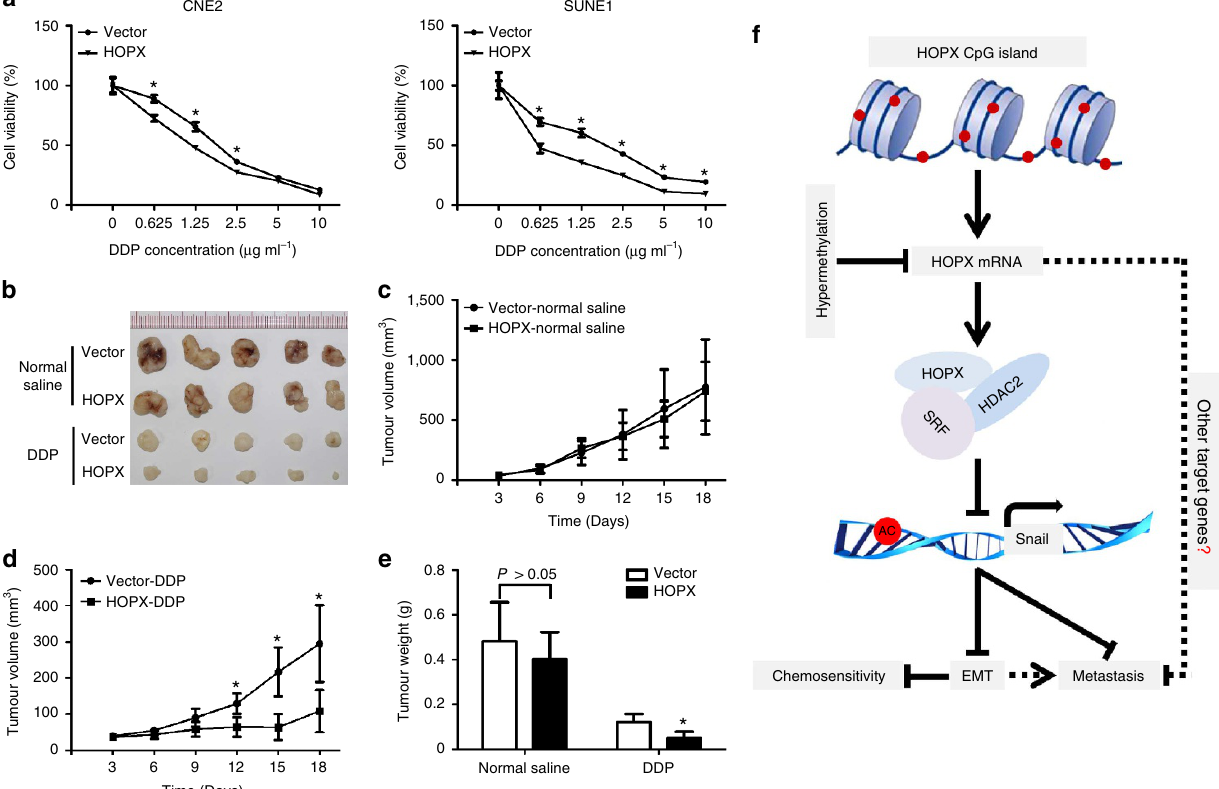
Figure 9 | HOPX enhances the sensitivity of NPC cells to DDP. ( a ) Dose–response curves of CNE2 and SUNE1 cells that stably overexpressed the vector or HOPX following DDP (0, 0.625, 1.25, 2.5, 5 and 10 m gml (cid:3) 1 ) treatment. Mean ± s.d.; * P o 0.01 compared with vector; Student’s t -tests. ( b – e ) CNE2 cells stably overexpressed the vector or HOPX were injected into the dorsal flank of the mice. The mice were randomly divided into four groups ( n ¼ 5 per group) and treated with normal saline or DDP (4mgkg (cid:3) 1 ). These data are representative of five independent experiments (each mouse sample was considered as an independent experiment). ( b ) Representative picture of xenograft tumours in nude mice. ( c , d ) The growth curves of the tumour volumes in normal saline ( c ) or DDP ( d ) treatment group. Mean ± s.d.; * P o 0.01 compared with vector; Student’s t -tests. ( e ) The tumour weights in normal saline- or DDP-treatment group. Mean ± s.d.; * P o 0.01 compared with vector; Student’s t -tests. ( f ) Schematic summary of the HOPX-HDAC2/SRF- SNAIL